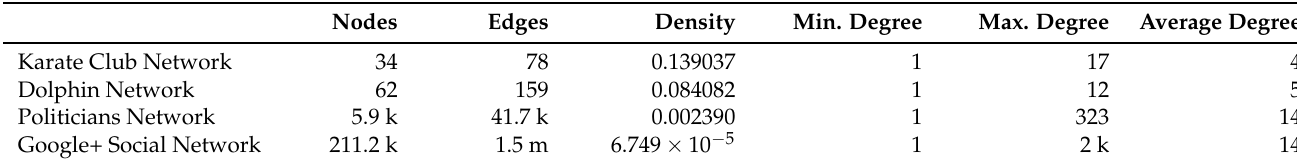
Table 2. Attributes of the networks used in the experiments.